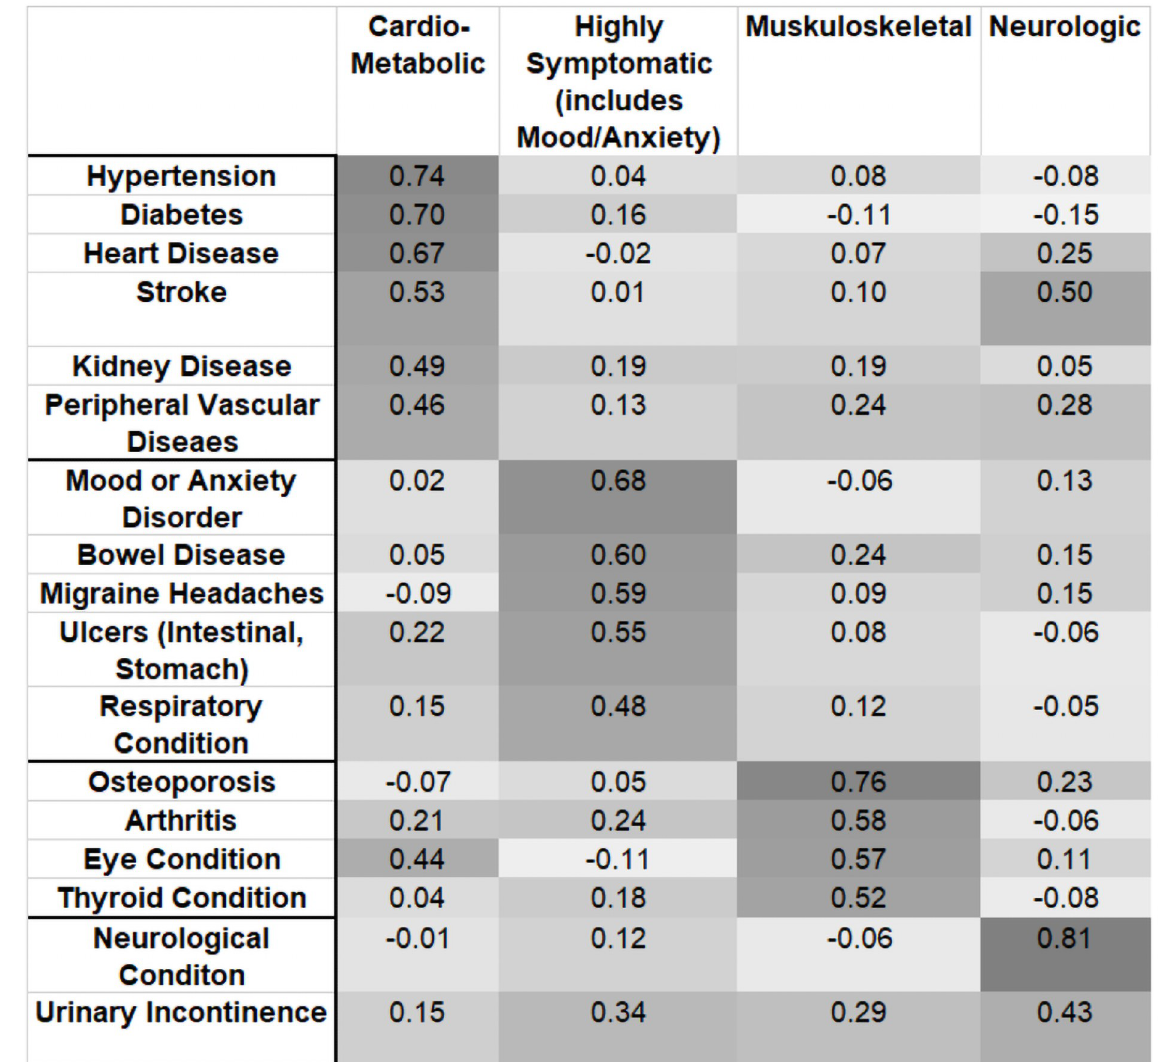
Fig 5. Chronic condition clusters—factor loadings from rotated factor